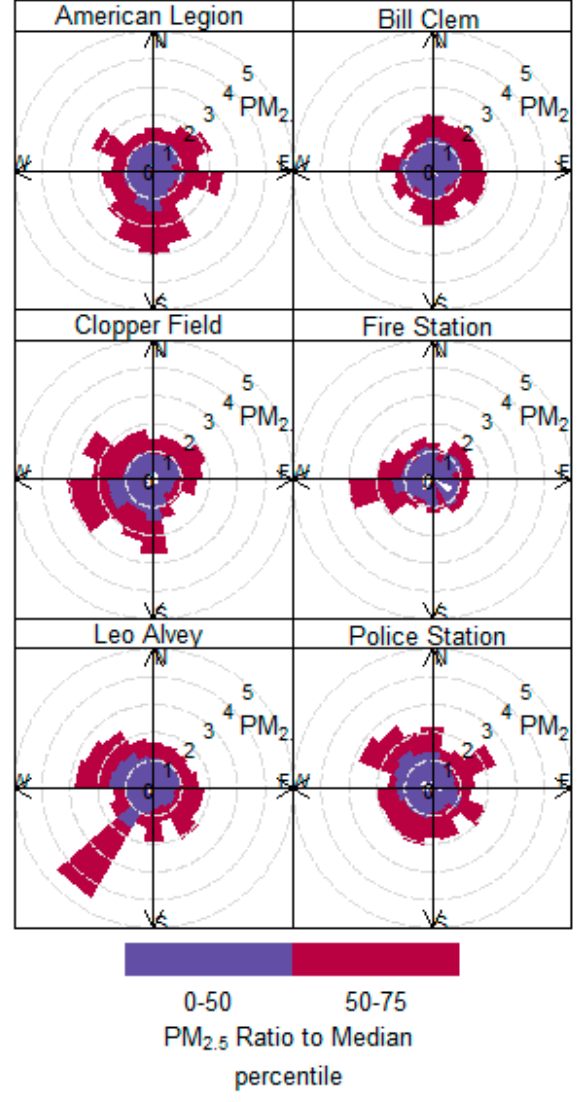
Figure 6. PM 2.5 Pollution rose for all sites.